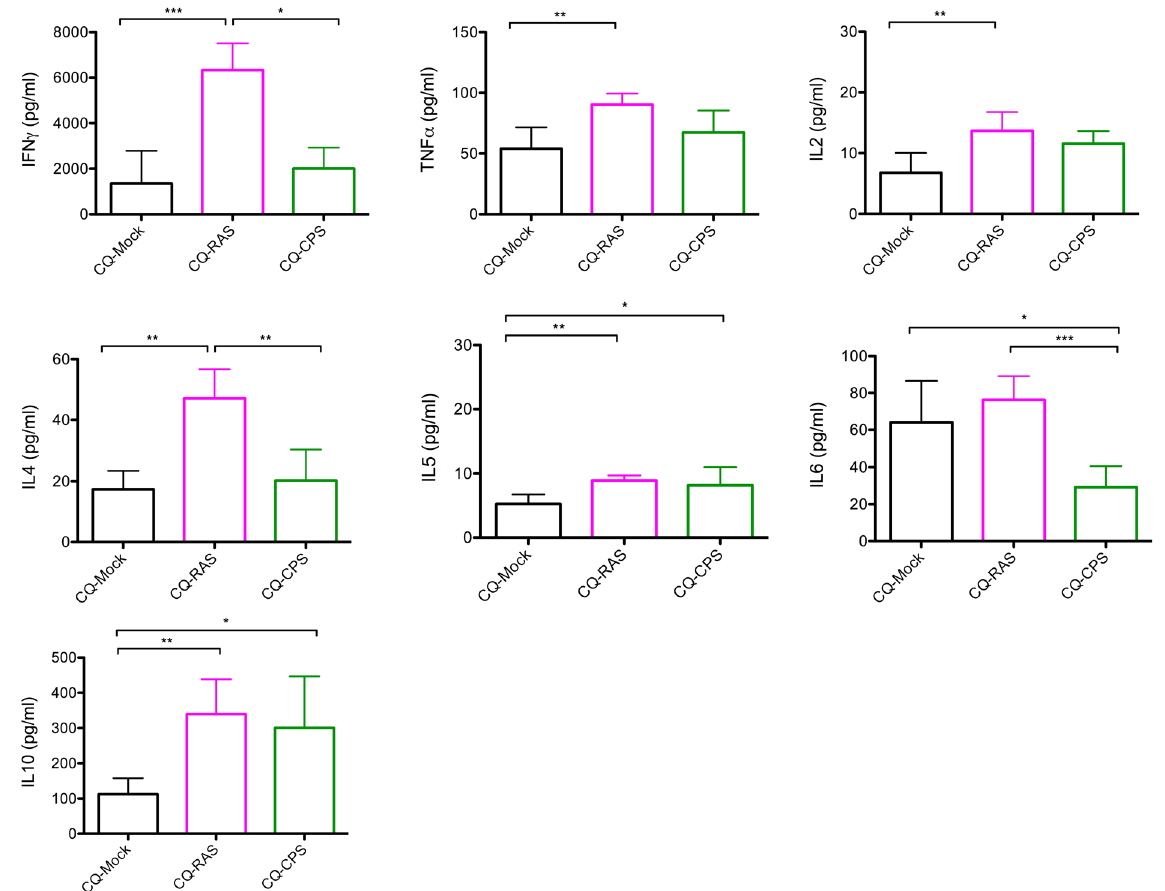
Figure 6. Assessment of cytokine levels in CQ-RAS (n = 8) and CQ-SPZ (n = 8) immunized mice versus CQ- Mock controls (n = 8). The plasma levels of IFNy, TNF- α , IL2, IL6, IL4, IL5 and IL10 were measured 4 days after infection (post-challenge) with 10 5 iRBC. * P < 0.05; ** P < 0.01; *** P < 0.001 (Kruskal- Wallis test with Dunn’s Multiple